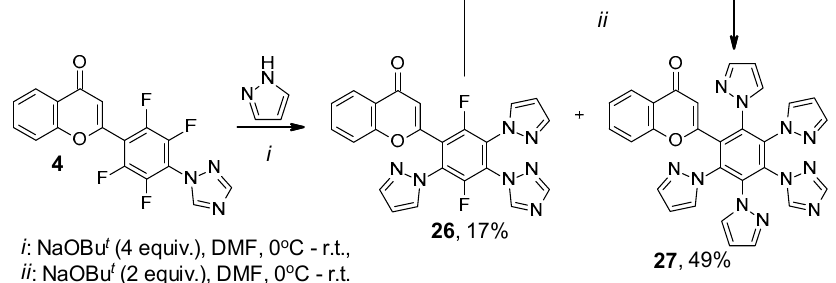
Scheme 7. Reaction of flavone 4 with pyrazole.